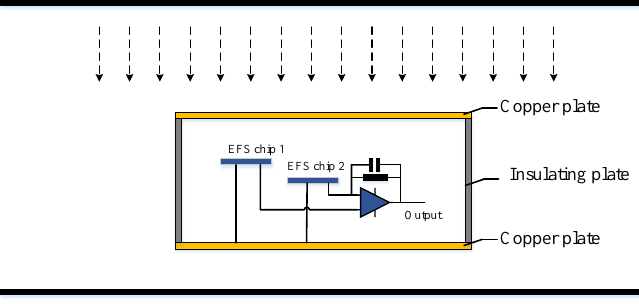
Figure 4. MEMS electric sensor in ion flow field.